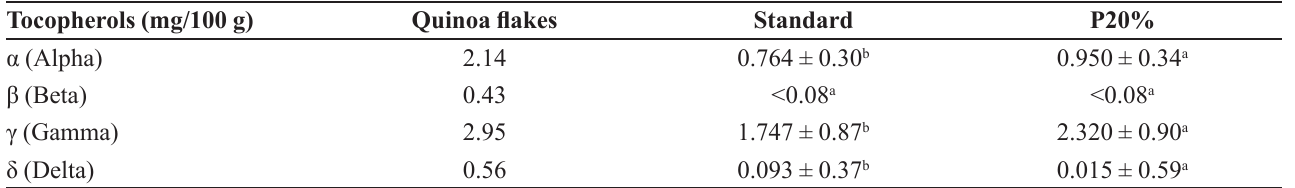
TABLE IV - Quantity and types of tocopherols found in quinoa flakes and standard and 20% quinoa loaves Tocopherols (mg/100